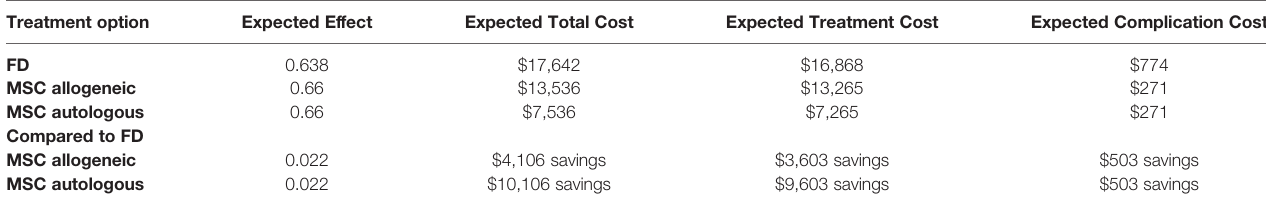
TABLE 1 | Base Case